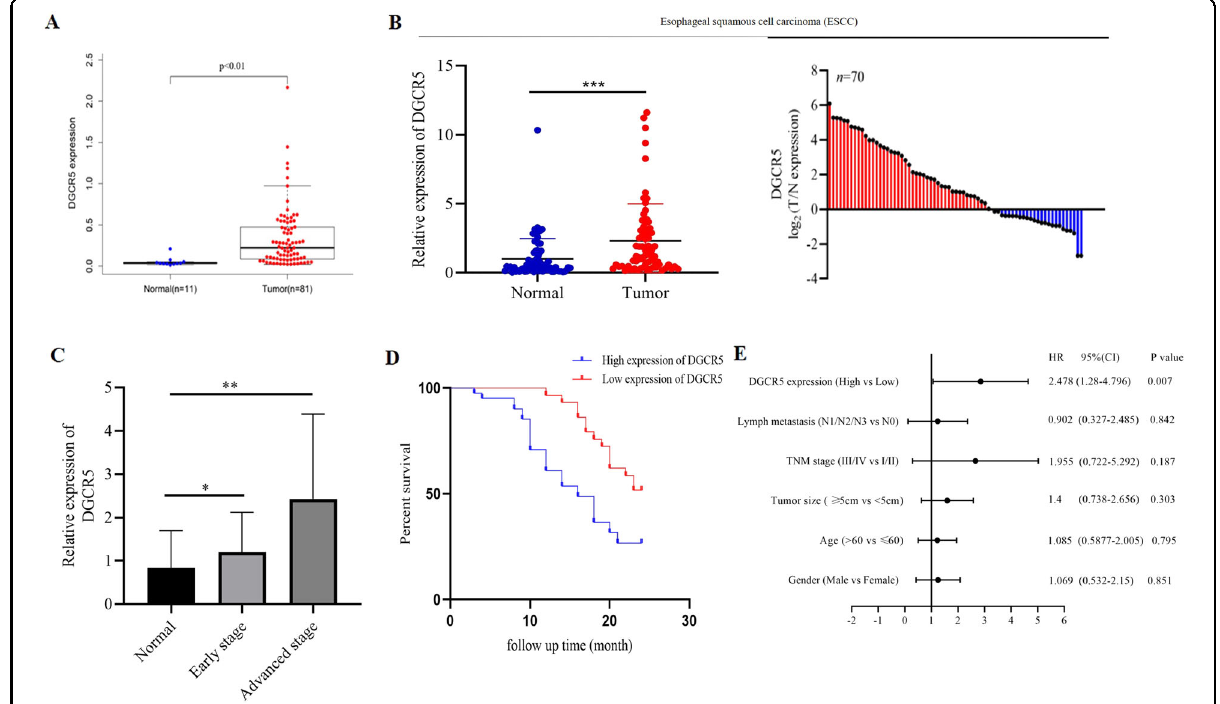
Fig. 1 The expression of DGCR5 in human ESCC tissues and normal tissue samples. A DGCR5 expression level was observed in ESCC tissues from the TCGA database. B DGCR5 expression was analyzed by qRT-PCR from 70 pairs of ESCC samples and non-tumor tissues. GAPDH was used as a control. C DGCR5 expression levels in different tumor stages. D Kaplan – Meier survival analysis showed the relationship between DGCR5 and prognosis. E DGCR5 is an independent prognostic factor in ESCC patients. ** P < 0.01 and * P <